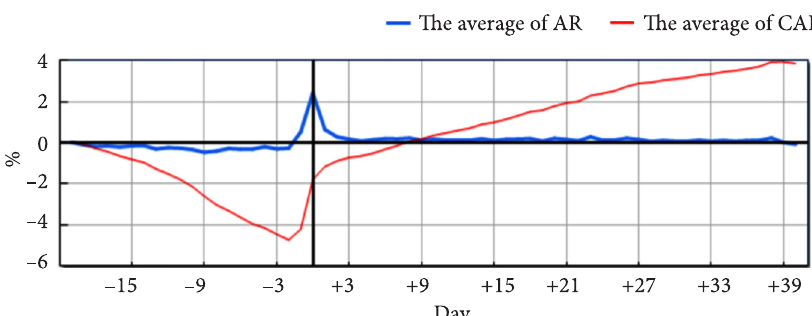
Figure 1. The line chart of stock price responses in the share repurchase event period [–20,